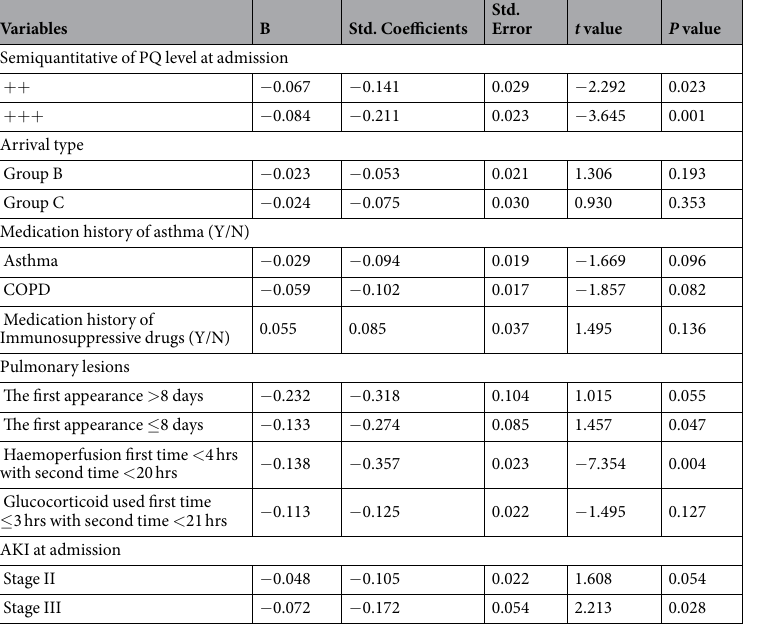
Table 3. Multiple logistic regression analysis to identify independent factors of HP therapy survival probability. AKI: Acute kidney injury. HP: haemoperfusion. Group B: Patients were transferred to us after first aid. Group C: Patients were transferred from more than one